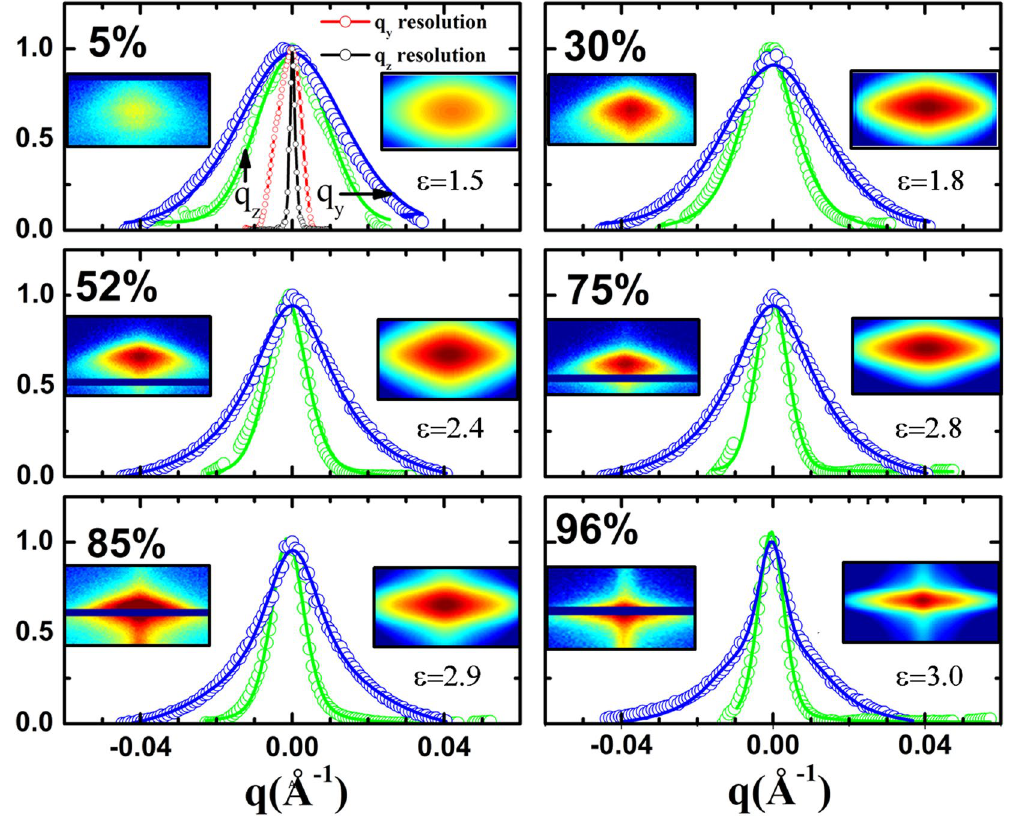
Figure 4. Intensity profile across the (0, 0, 2) spot as a function of humidity along q z (green) and q y (blue) directions plotted together in the same scale. The measured resolution functions in the two directions are shown in top left frame. The peaks were fitted using pseudo Voigt function. The measured and the calculated intensity- shape of the peaks are shown for all the RH values along with the obtained eccentricity determined from peak width-ratio. In each panel we have shown calculated intensity-shape I(q y , q z ) of (0, 0, 2) spot with the measured shape. Calculated shapes represent the measured data well – the associated eccentricity ε for each RH values are also shown in each